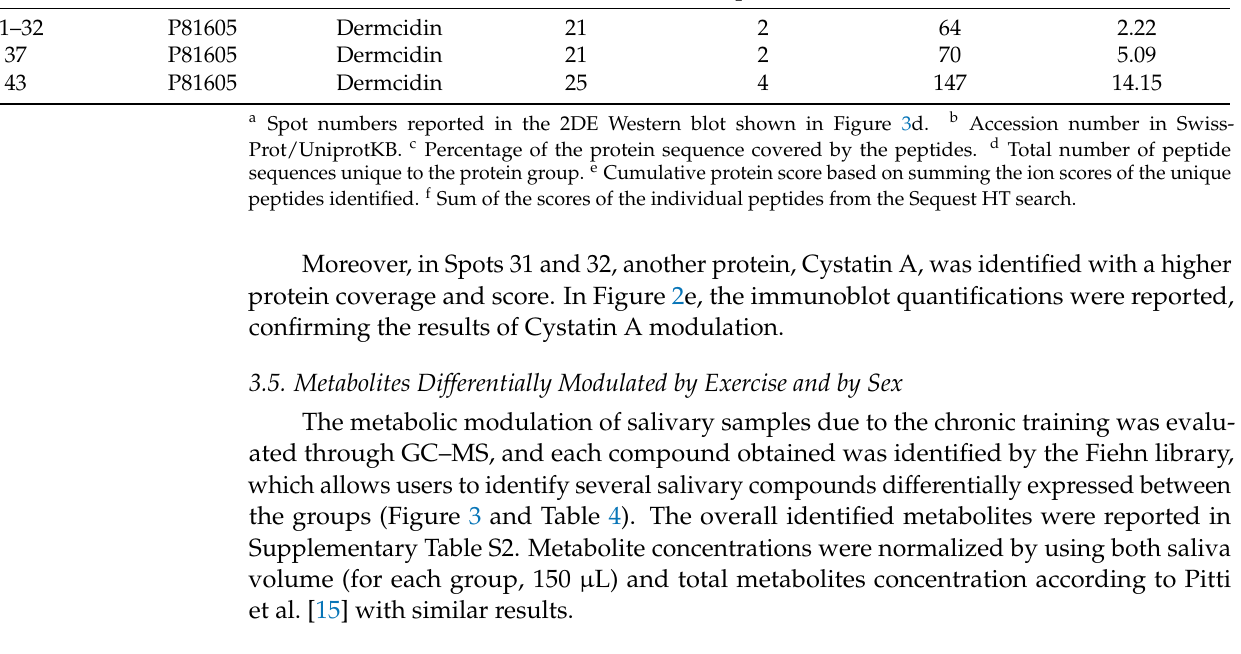
Table 4. Differentially expressed metabolites identified in saliva samples by gas chromatography– mass spectrometry (GC–MS)